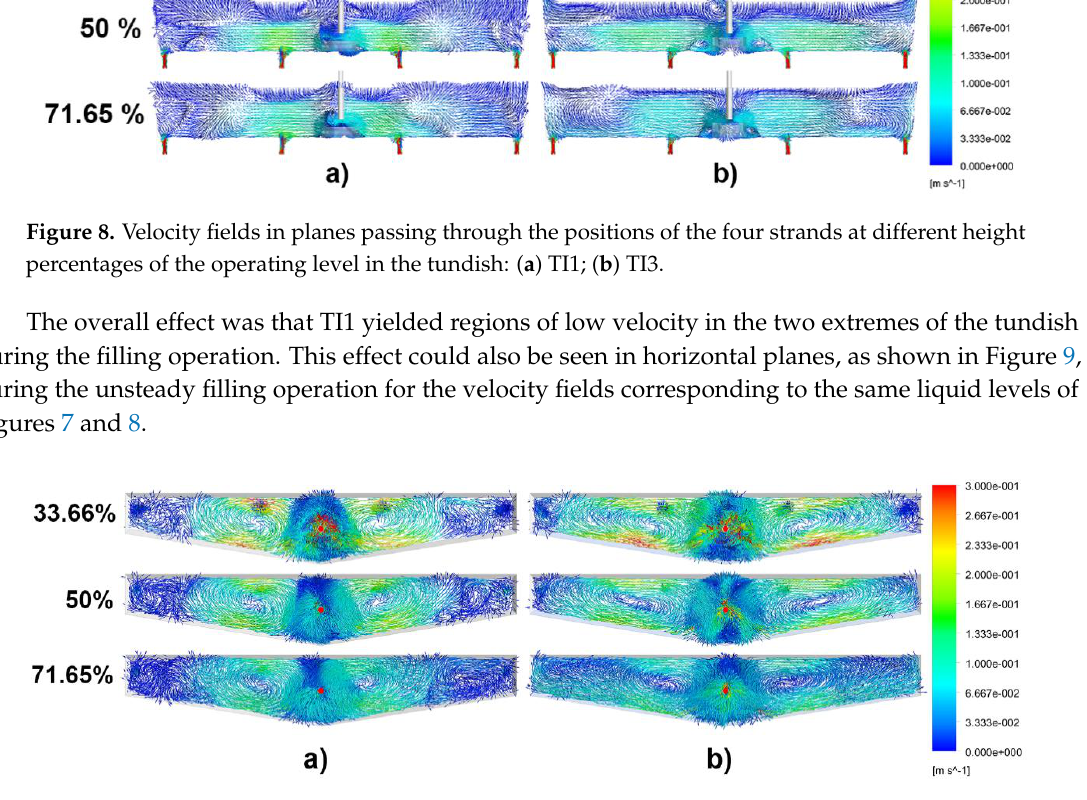
Figure 11. Velocity fields in vertical planes passing through the axis of the ladle shroud: ( a ) TI1 and ( b ) TI3. Velocity fields in planes passing through the four strands: ( c ) TI1; ( d ) TI3. 3.3. Experimental and Numerical RTD Curves A pulse injection of a red dye tracer was injected in the ladle shroud of the water model to determine the RTD curves following the principles explained in chemical engineering textbooks [2,16] under steady-state conditions and full tundish level. These simulations had a twofold purpose: first, to corroborate the predictive capacity of the mathematical model, and second, to demonstrate that even under steady conditions the fluid flow patterns created by each inhibitor during the tundish filling operation prevailed. Therefore, the performance of both inhibitors to control the flow and overall RTD curves were determined using the equations presented in the lower part of Table 2. The outputs of this procedure are reported in the upper part of Table 2, and from these results the following observations were established: •